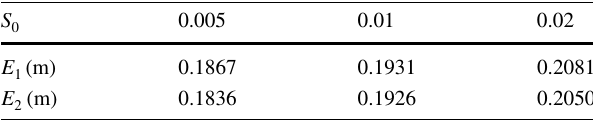
Table 5 Changes in simulated specific energy for main channel with different